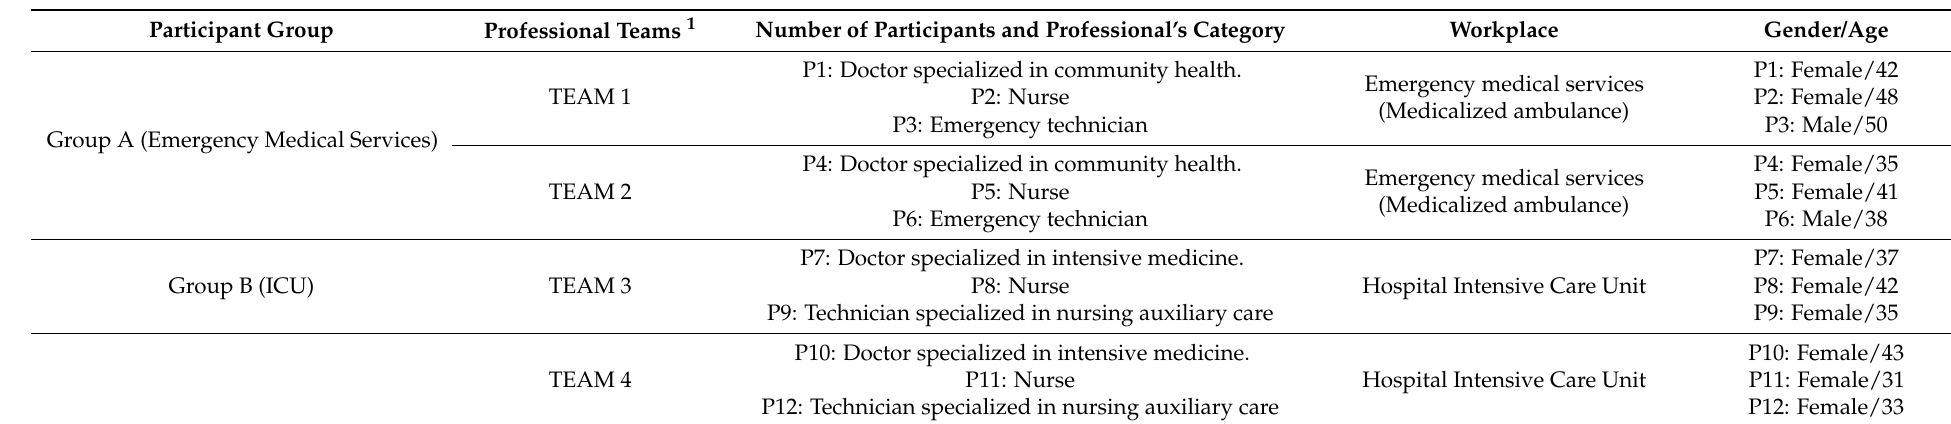
Table 1. Characteristics of the simulation study